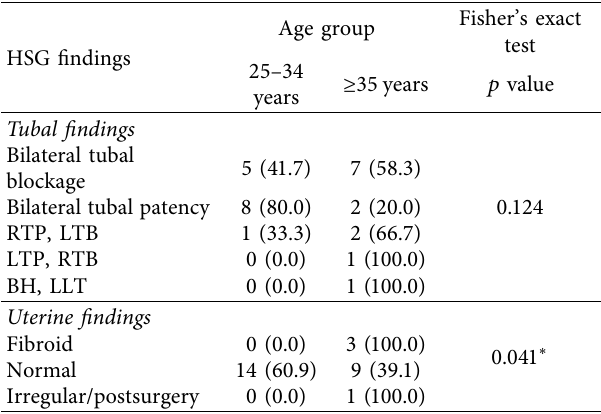
Table 2: Distribution of HSG findings by the age group of infertile women under ketamine sedation.